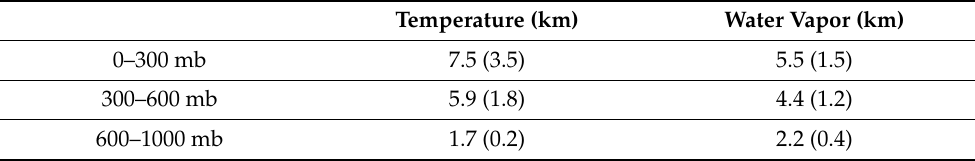
Table 3. Mean vertical resolution (km) from successful IR + MW retrievals of temperature and water vapor for flight matches. Standard deviations are shown in parentheses. Statistics incorporate 112 NUCAPS